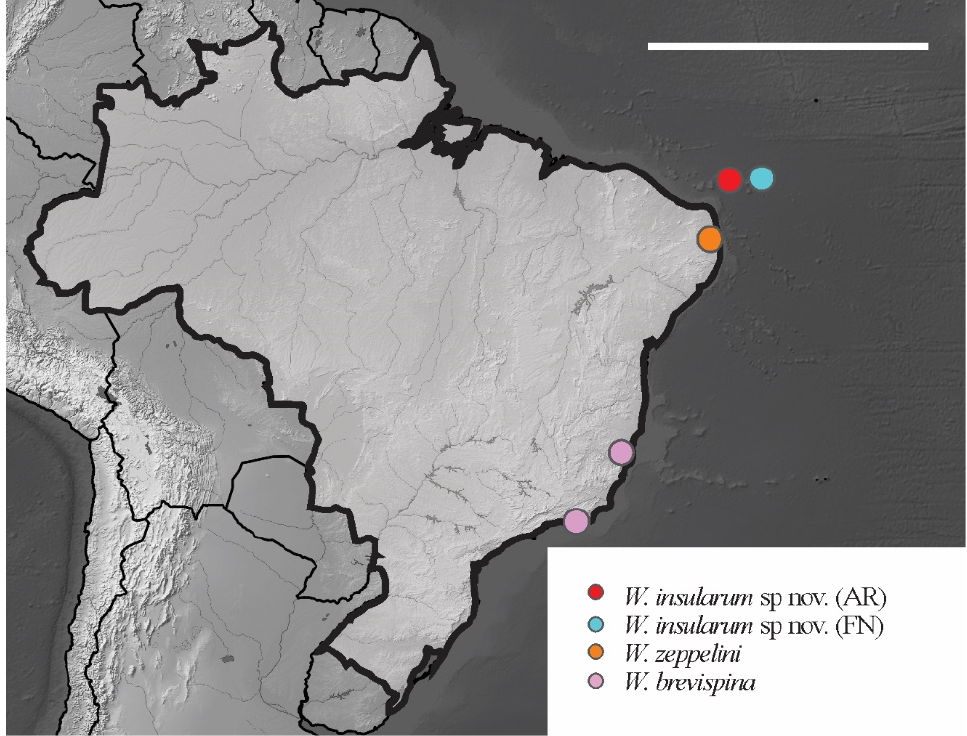
Distribution . The new species were found on Fernando de Noronha and Atol das Rocas Islands in the SF sites. The specimens were collected in sand near the psammophile vegetation, litter and seabird guano. For the congeners registered in Brazil, see Figure 24.